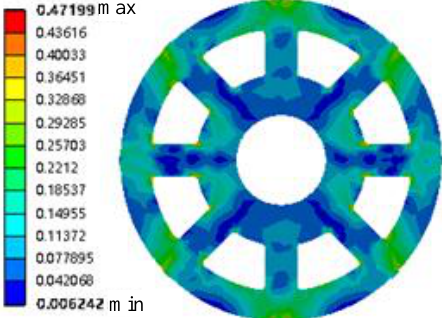
Figure 17. Strain distribution diagram of the rotor shutdown condition. Figure 16. Stress distribution diagram of the rotor shutdown condition.